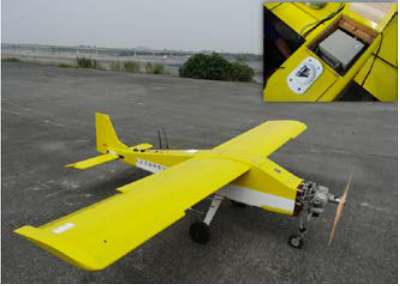
Figure 3. Appearance of AL-40 UAS